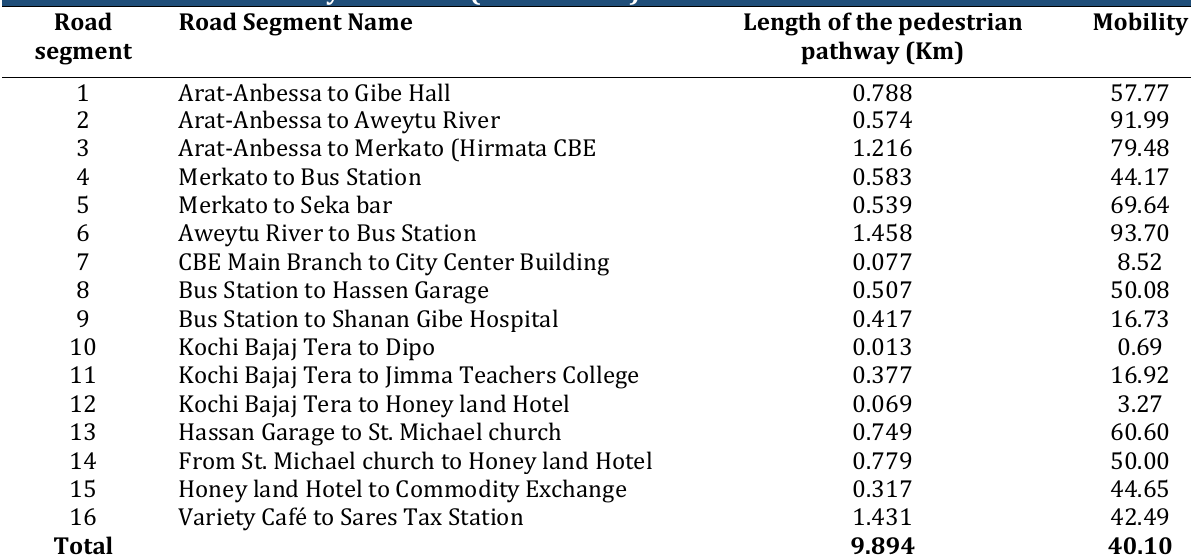
Table 4: Values of mobility indicator (M-indicator) Road